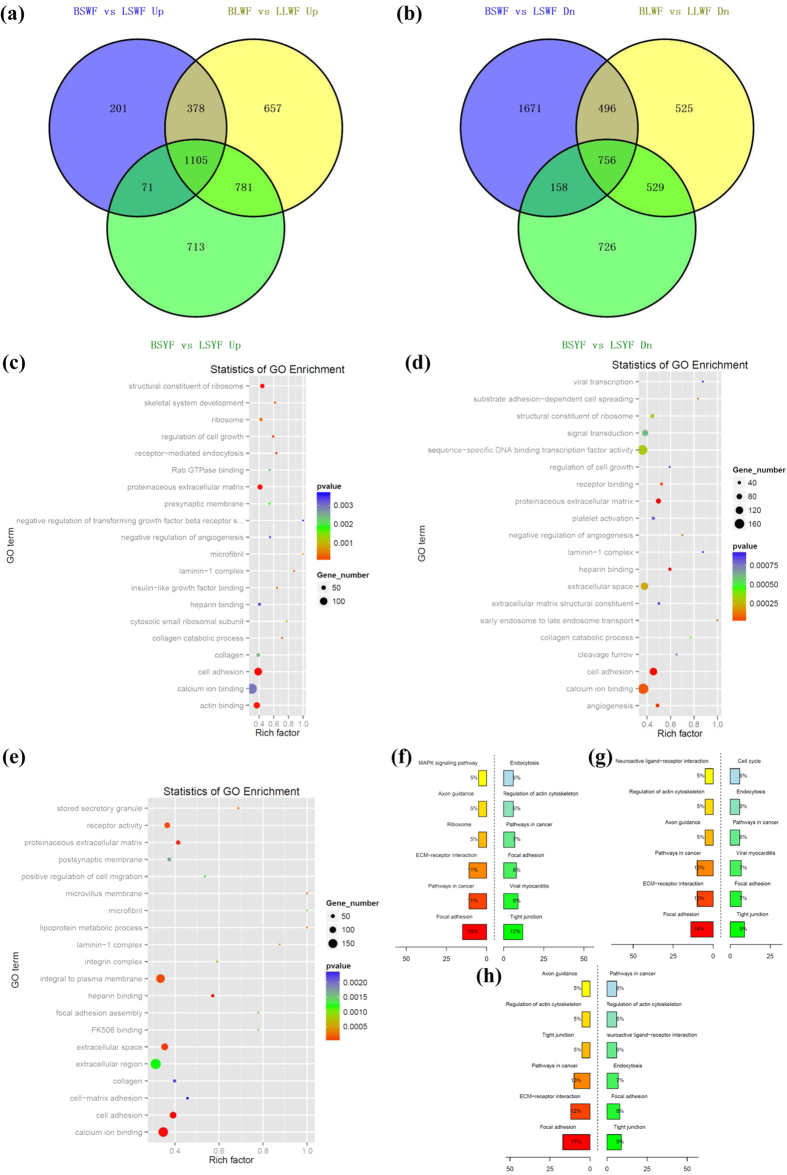
Analysis of differentially expressed genes during the period egg-laying and broody goose follicles.(a) Up-regulated genes of SWF, LWF and SYF from egg-laying and broody geese. SWF, small white follicles; LWF, large white follicles; SYF, small yellow follicles; the character L stands for egg-laying goose and the character B stands for broody goose. (b) Down-regulated genes of SWF, LWF and SYF from egg-laying and broody geese. (c) Analysis of biological functions of GO-enriched genes from LSWF and BSWF. (d) Analysis of biological functions of GO-enriched genes from LLWF and BLWF. (e) Analysis of biological functions of GO-enriched genes from LSYF and BSYF. (f) KEGG pathway enrichment analysis of differentially expressed genes from LSWF and BSWF. (g) KEGG pathway enrichment analysis of differentially expressed genes from LLWF and BLWF. (h) KEGG pathway enrichment analysis of differentially expressed genes from LSYF and BSYF.